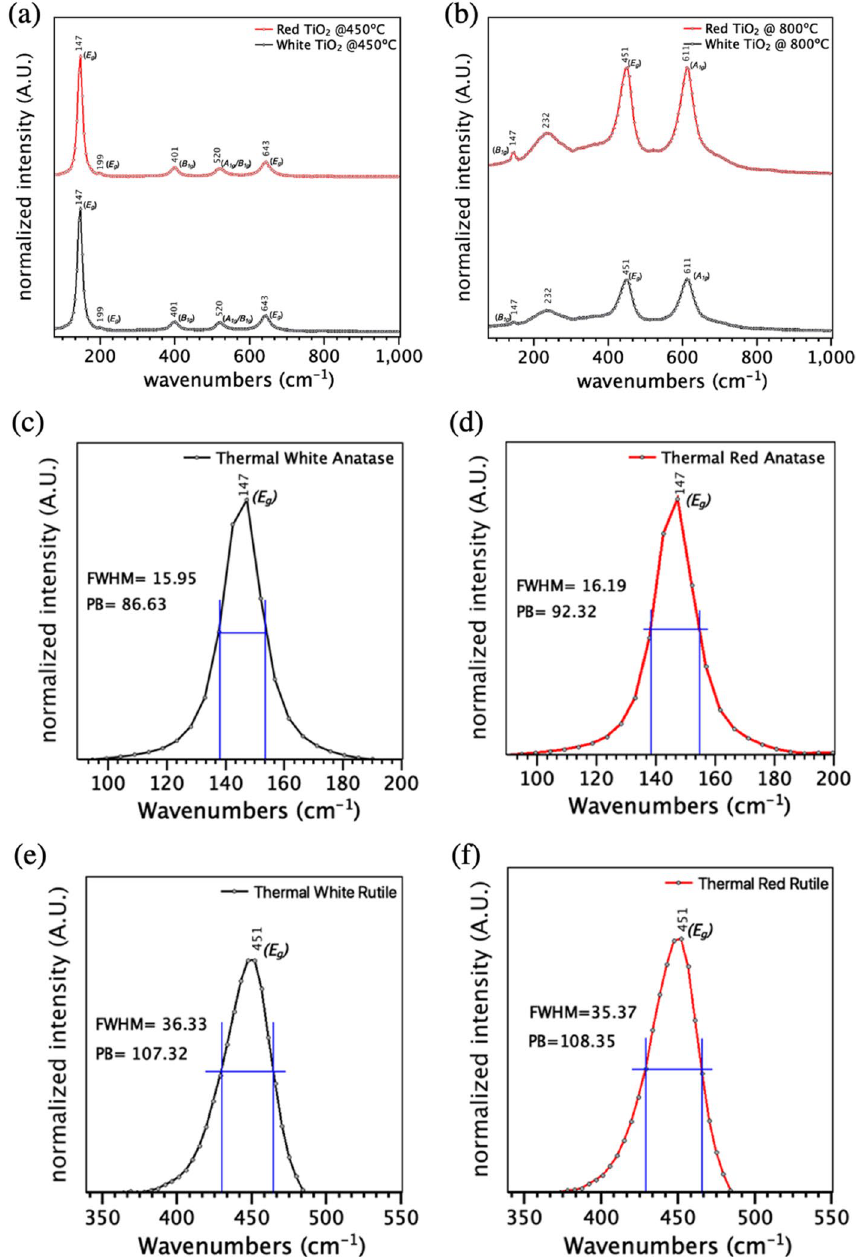
Figure 6. Raman spectra for the different polymorphs crystallized from the amorphous red and white TiO 2 . ( a ) White and red anatase TiO 2 powders crystallized at 450ºC. ( b ) White and red rutile TiO 2 powders crystallized at 800ºC. ( c , d ) E g mode of the white and red anatase TiO 2 powders crystallized at 450ºC. ( e , f ) E g mode of the white and red rutile TiO 2 powders crystallized at